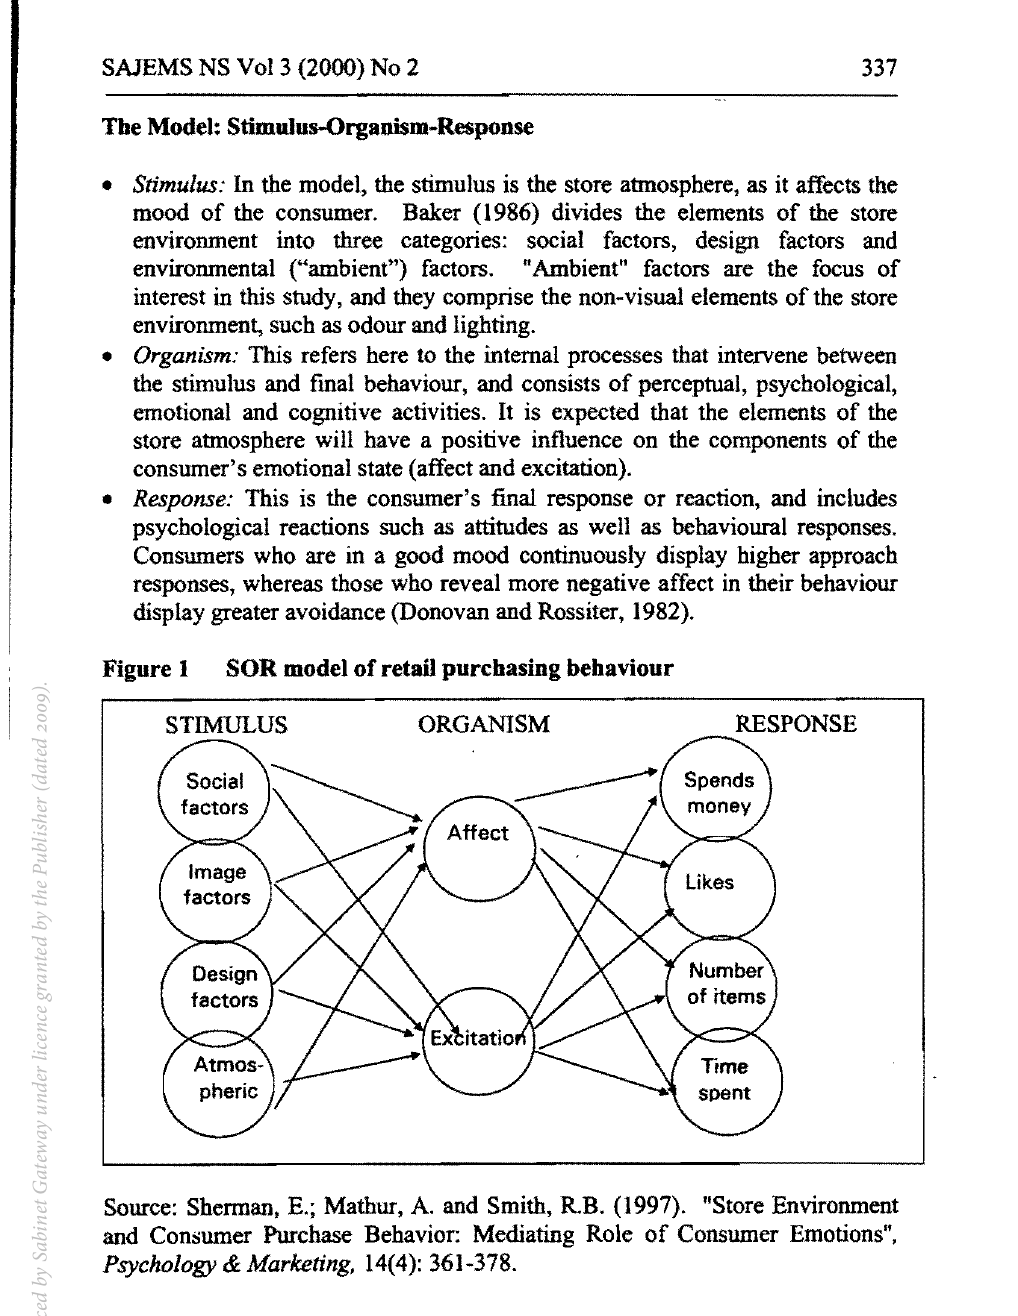
SOR model of retail purcbasing bebaviour STIMULUS ORGANISM